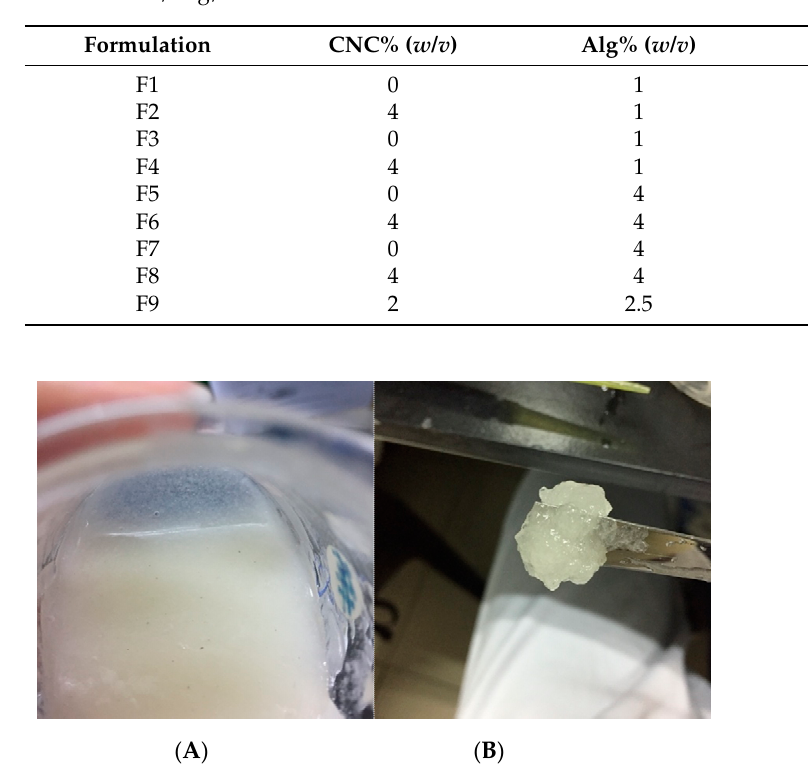
Figure 1. CNC/Alg/PEGDA pre-gel formulation in liquid form ( A ), and CNC/Alg/PEGDA gelled formulation after the addition of CaSO 4 ( B ). Table 1. CNC/Alg/PEGDA formulations .